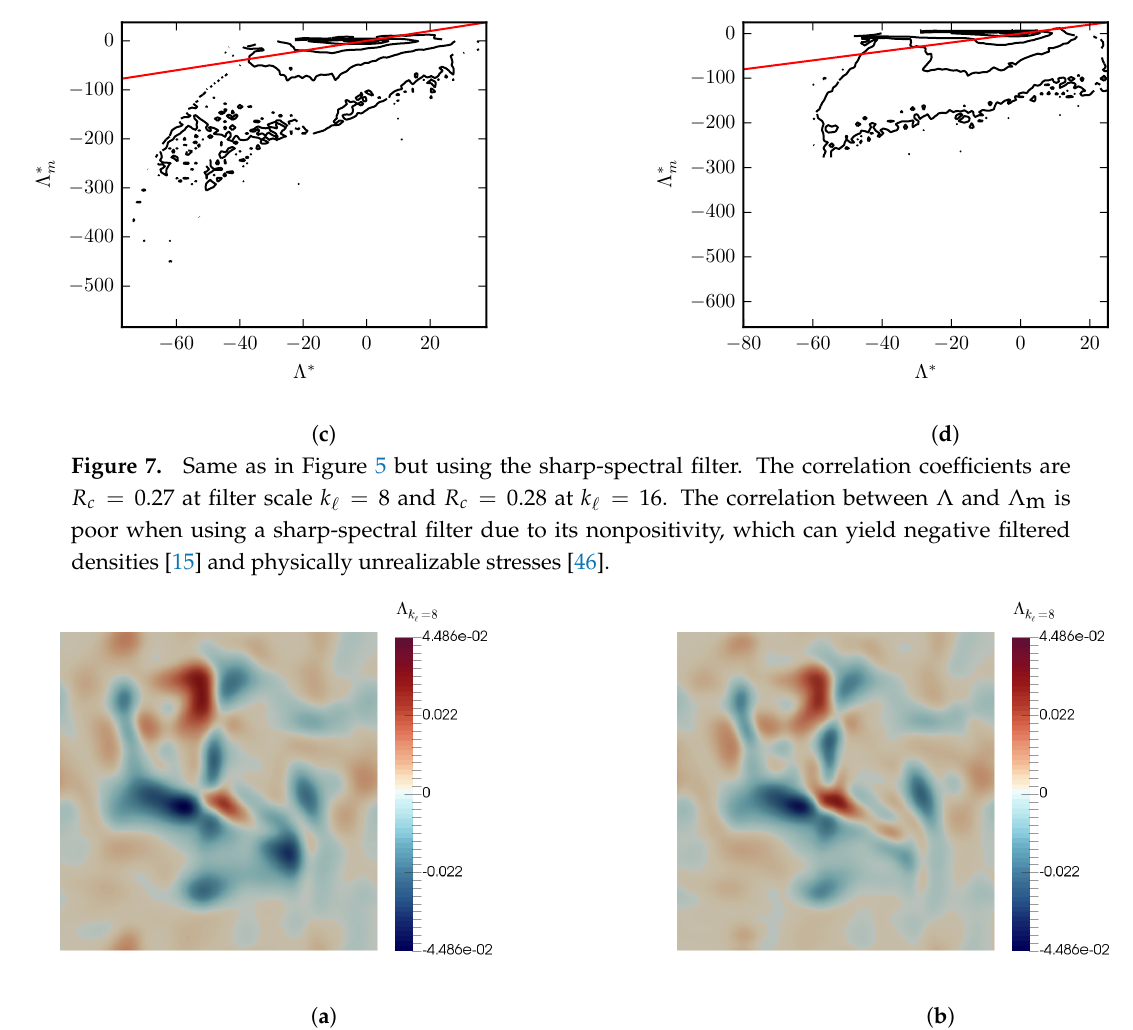
Figure 8. Pointwise comparison between ( a ) baropycnal work and ( b ) its nonlinear model from a 2D slice of the 3D domain in Run 1, at one instant in time. A Gaussian kernel at scale k (cid:96) = 8 is used. The visualizations show excellent pointwise